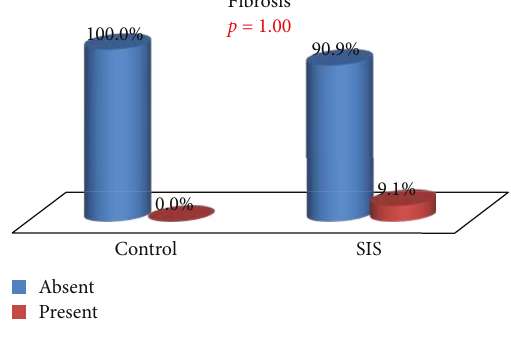
Figure 13: Control group without cartilaginous tissue regeneration Figure 10: Fibrosis: group comparison. (newly formed cartilage) at the site of the tracheal defect, H&E (100x): (a) mature cartilaginous tissue, (b) pseudostrati fi ed ciliated epithelium, (c) connective tissue, (d) blood vessels, (e) fi brosis, and (f) acute and chronic in fl ammatory